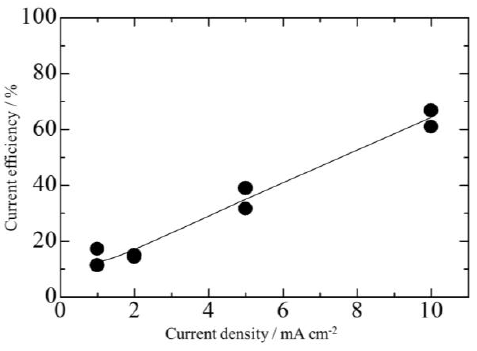
Figure 9. The relationship between current density and current efficiency.